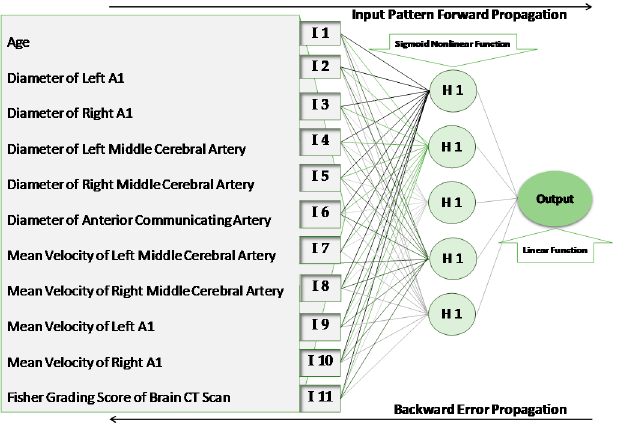
Figure 1. The structure of the artificial neural network. I, input unit; H, hidden unit. The units within each layer of the model were connected with the units of the adjacent layers through directed edges (weights). There were no connections between the units within the same layer [14]. A nonlinear Sigmoid function was applied to the hidden layer, and a linear function was applied to the output